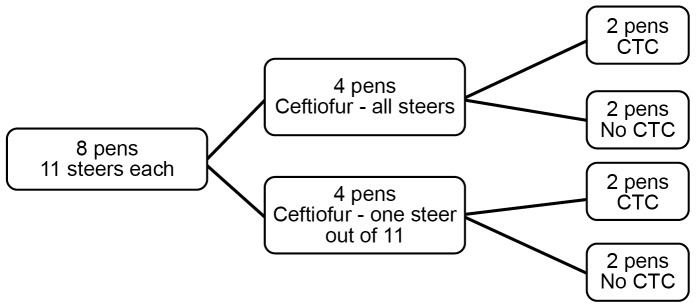
Schematic diagram of the study design.The two sets of treatment strategies were assigned in a two-way full-factorial manner. Number of pens assigned to each treatment and number of animals within each pen are shown above.